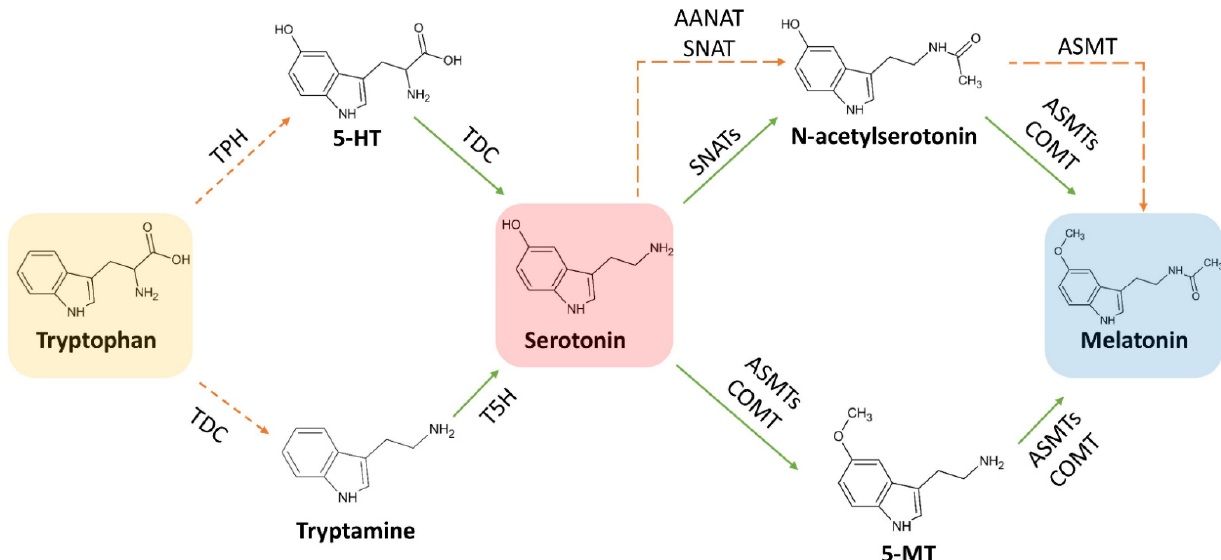
Figure 8. The melatonin biosynthetic pathway in mitochondria (orange broken arrows) and in chloroplasts (solid green arrows). In plants both pathways are probably present: when the main chloroplast pathway is interrupted (like in Sekiguchi mutant rice) the mitochondrial pathway takes over to compensate for the lack [85,86]. TDC: L-tryptophan decarboxylase; TPH: tryptophan hydroxylase; T5H: tryptamine 5-hydroxylase; SNATs: serotonin N-acetyltransferase; ASMTs: acetylserotonin O-methyltransferase; COMT: caffeic acid 3-O-methyltransferase.